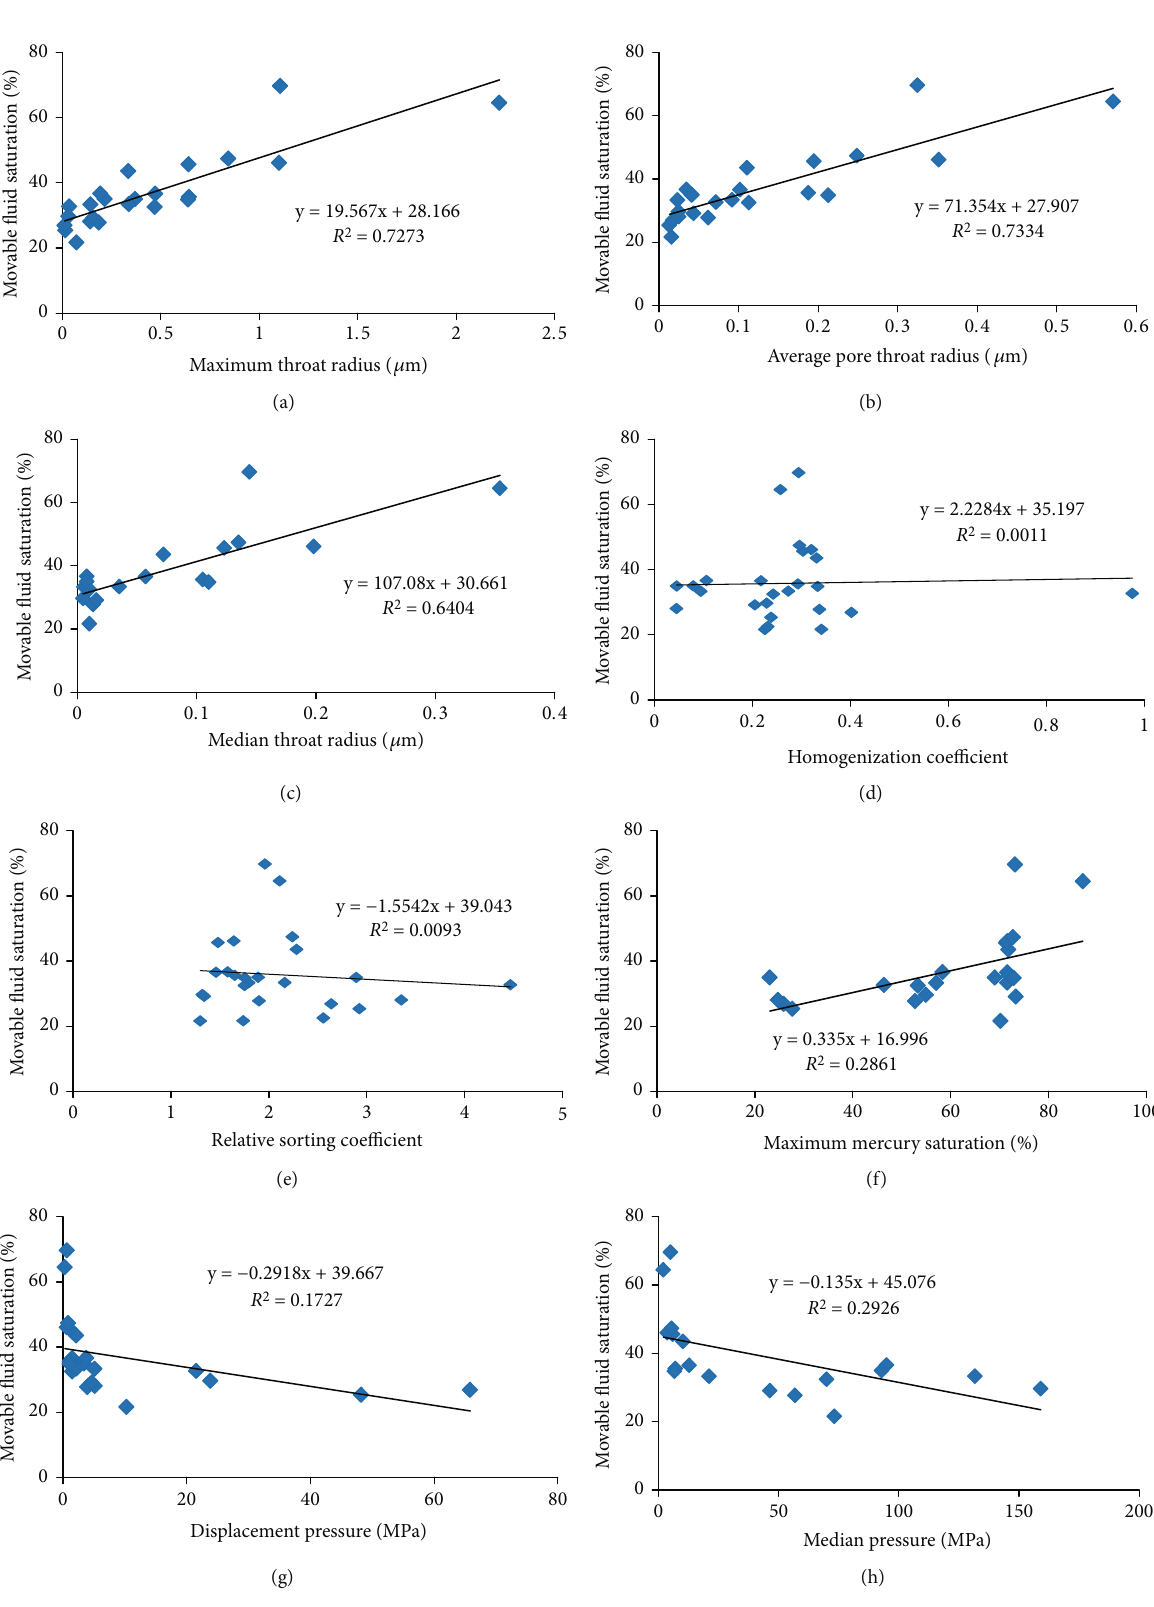
Figure 9: Reservoir pore structure parameters and movable fl uid